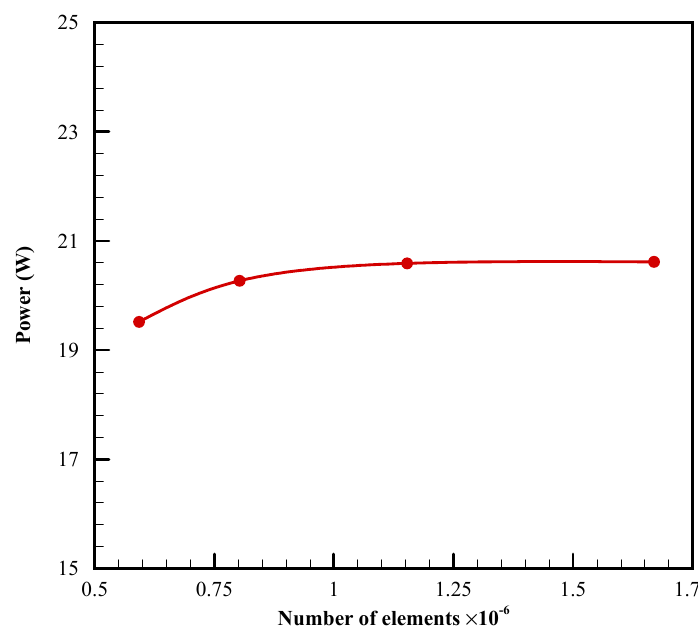
Figure 2. Grid independence check.